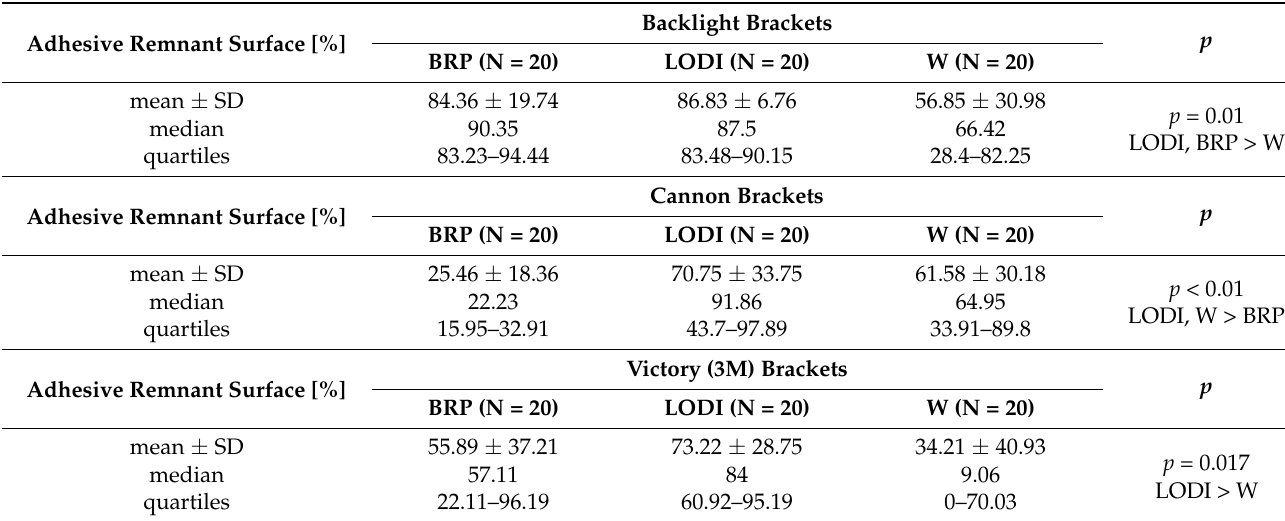
Table 2. Comparison of the amount of adhesive remaining on the enamel after debonding according to the debond- ing method.